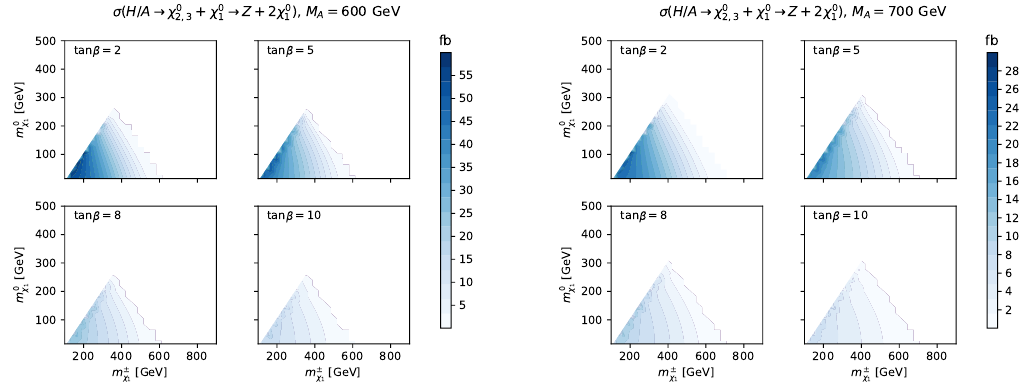
Figure 9 . The production cross-section for the process H=A electroweakinos, with heavy scalar mass m A = 600 ; 700 GeV and tan (cid:12) = 2 ; 5 ; 8 ; 10.